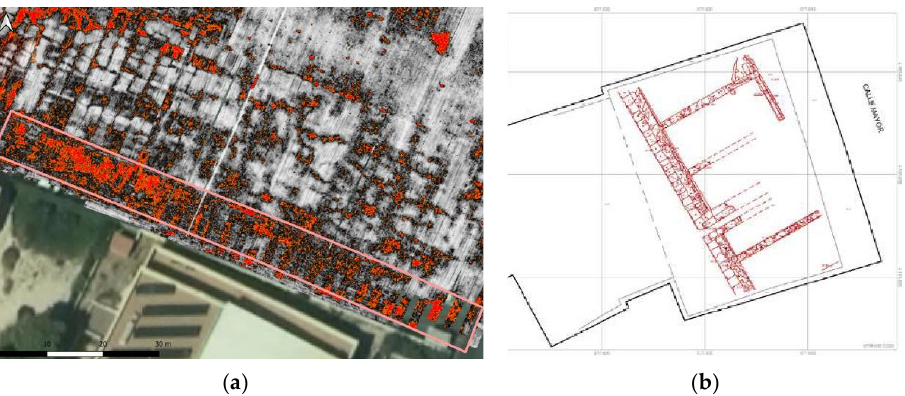
Figure 14. ( a ) Detailed view of the southern part of the study area showing the alteration of Set 1 at − 0.89 m. ( b ) Plant of the Roman port structure exhumed in Cartagena [19] (p. 358, Figure